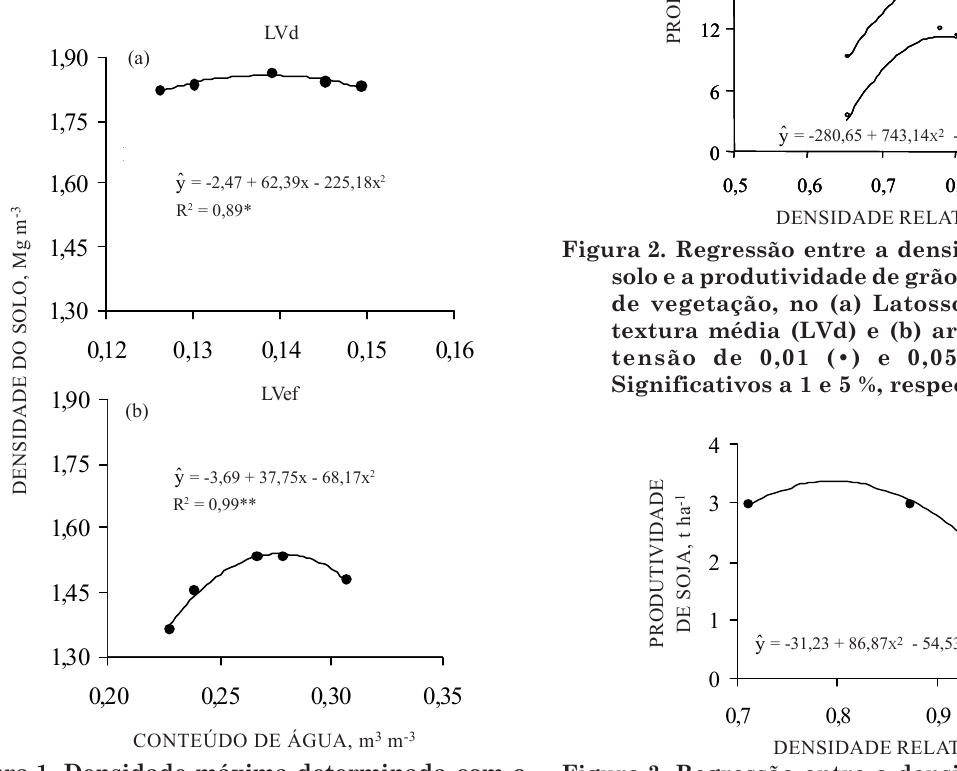
Figura 3. Regressão entre a densidade relativa do solo e a produtividade de grãos de soja, no campo, no Latossolo Vermelho de textura média. * Significativo a 5